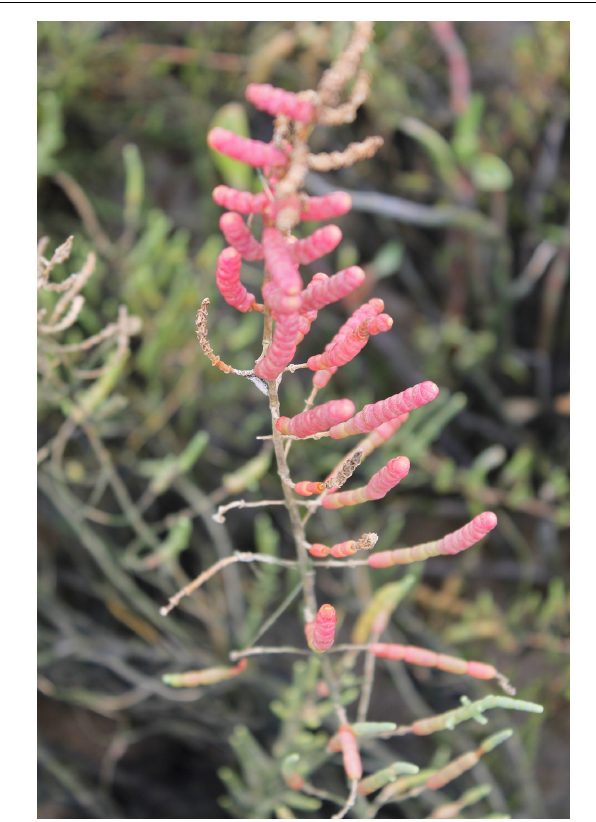
FIGURE 12 | Sarcocornia fruticosa exhibiting a red coloration during the summer due to excessive salt concentrations in the sediments Photo by B. Duarte (2012).